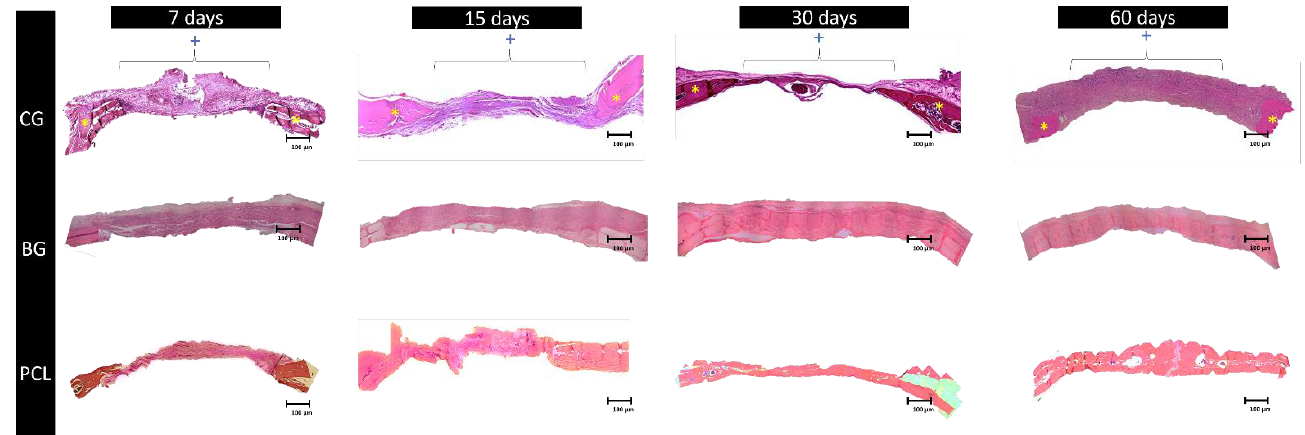
Figure 1. Photomicrographs at the panoramic reconstruction of histological sections ( × 6.3) for the experimental groups (CG (clot group), BG(Bio-Gide ® group), and PCL(polycaprolactone group)) in all periods analyzed (7, 15, 30, and 60 days postoperatively). The BG and PCL groups performed better at 60 days, demonstrating the ability to close the bone defect. The PCL group showed good closure of the defect, with particles of polycaprolactone and nanohydroxyapatite (nHA) surrounded by osteoid tissue. Asterisks (*) represent regions of bone stumps; plus signs (+) represent the horizontal extension of the bone defect.